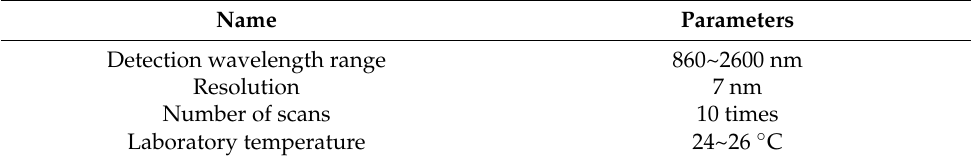
Table 2. Experimental parameter setting table.